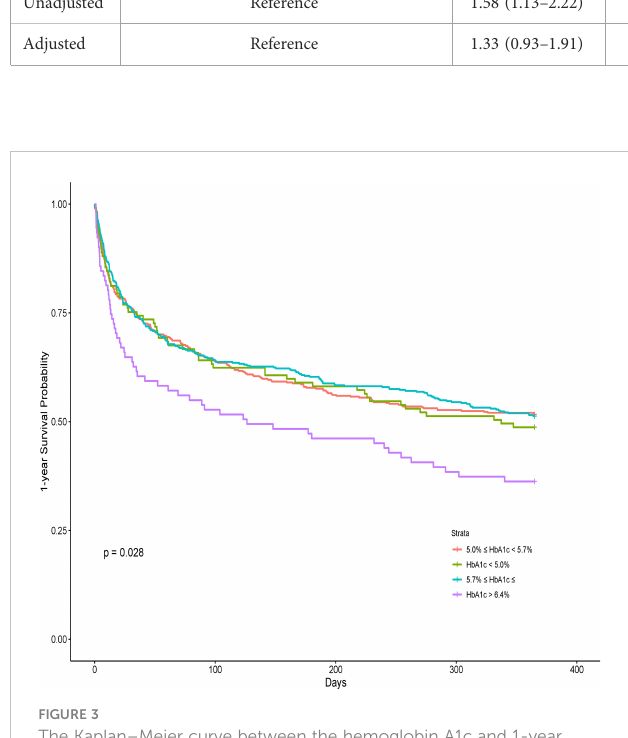
FIGURE 3 The Kaplan – Meier curve between the hemoglobin A1c and 1-year mortality after PSM.